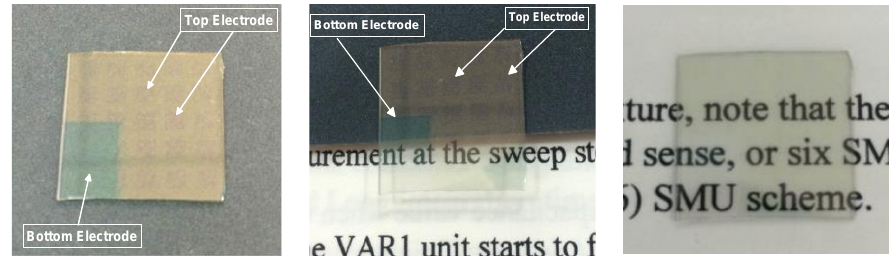
Figure 12. The transmittance of ITO/ITO X /ITO RRAM for the visible wavelength range of 400 – 800 nm.